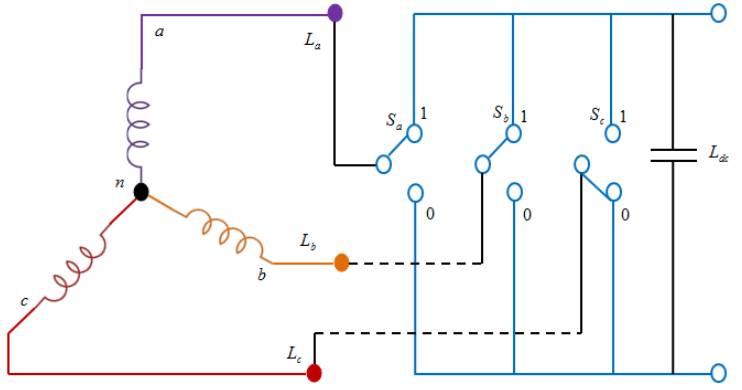
Figure 3. Recti fi er connection diagram. Figure 3. Rectifier connection diagram.